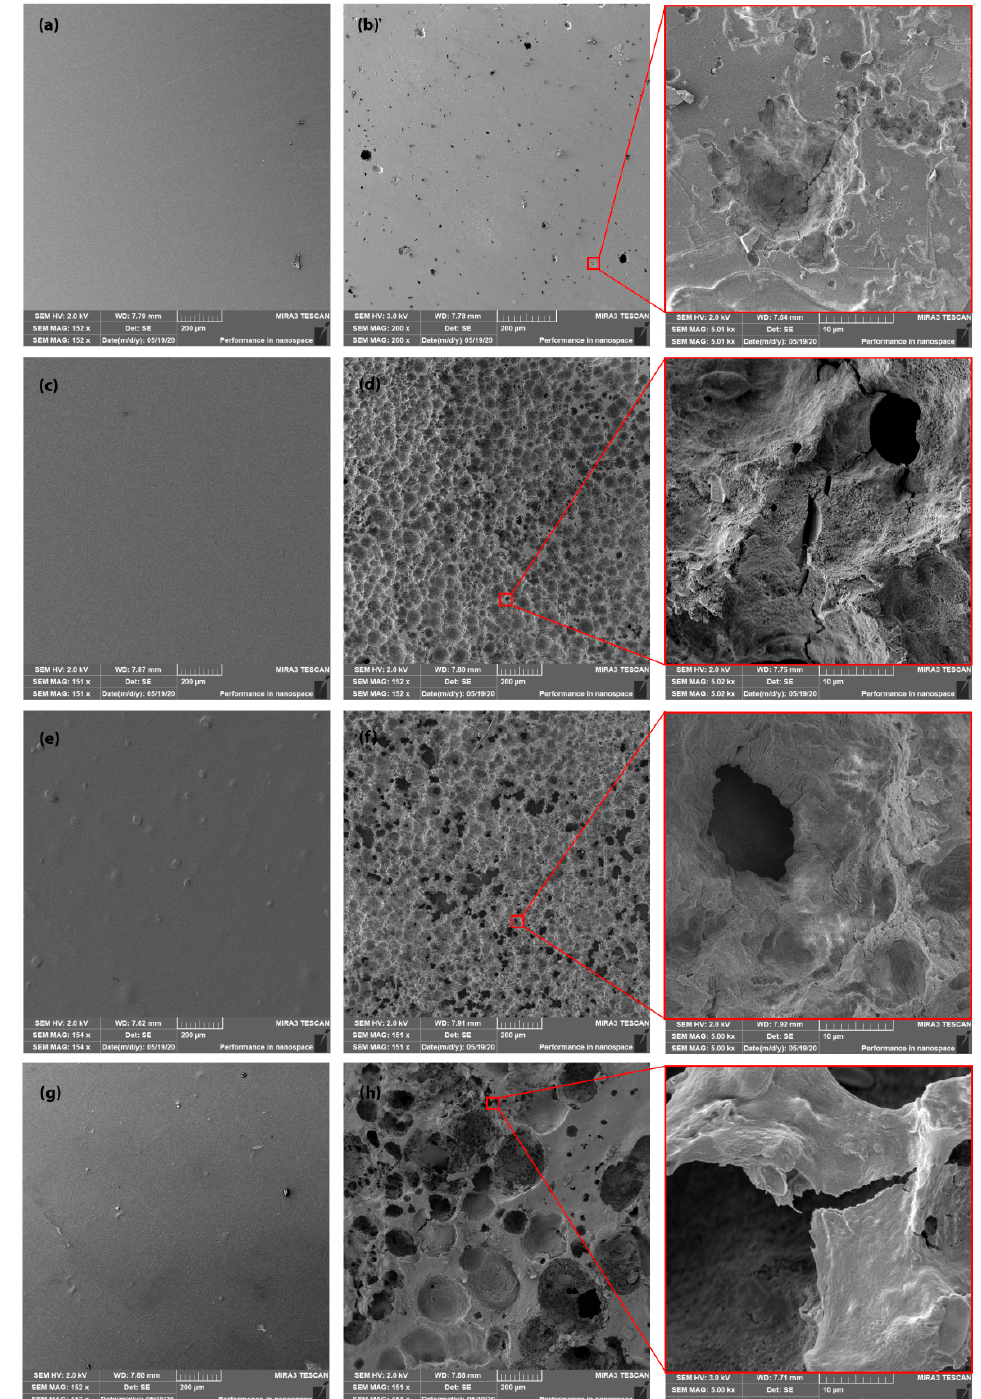
Figure 5. SEM images of ( a ) neat PLA film at initial state, ( b ) neat PLA film after three months of biodegradation, ( c ) PLA/ATBC at initial state, ( d ) PLA/ATBC after three months of biodegradation, ( e ) PLA/ATBC/L-CNC at initial state, ( f ) PLA/ATBC/L-CNC after three months of biodegradation, ( g ) PLA/ATBC/CaCO 3 at initial state and ( h ) PLA/ATBC/CaCO 3 after three months of biodegradation.